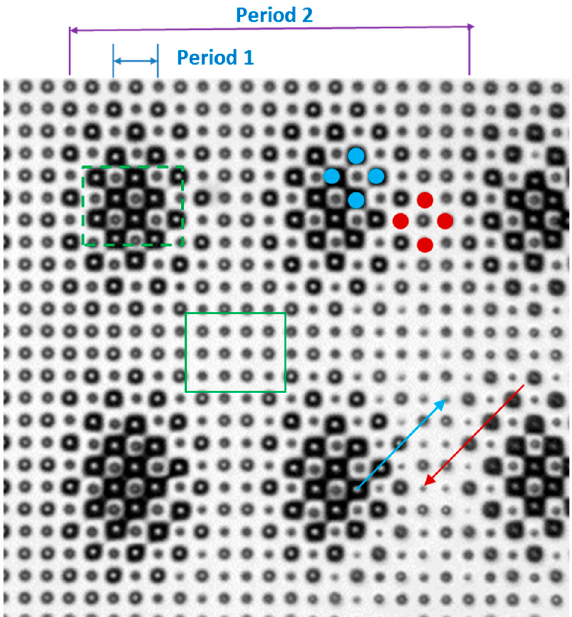
Figure 1. Image of a graded photonic super-crystals: the lattices can be grouped by blue and red dots. The size of the basis becomes smaller along the blue and red arrows, and then becomes larger after a quarter of “Period 2”. The filling fraction of the dielectric material is higher inside the dashed green rectangle than the solid green rectangle. The graded photonic super-crystals have a unit super-cell as indicated by Period 2 in x-direction.